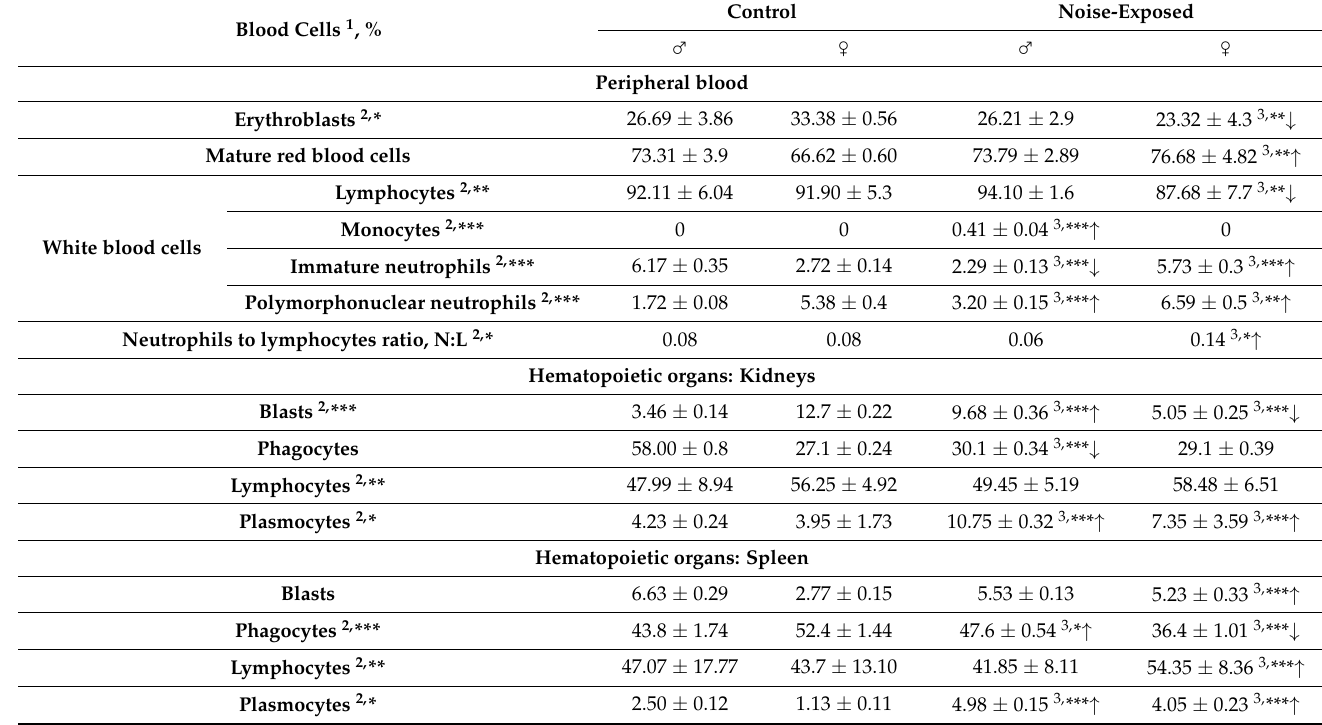
Table 1. Comparison of stone sculpin blood profiles (percentage of the total blood cells) in control and following seven days of noise